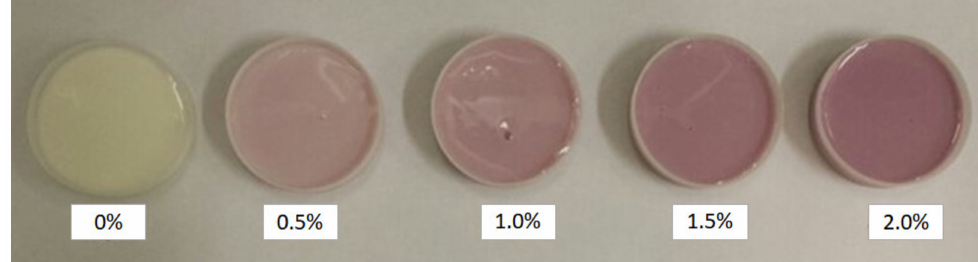
Figure 1. Appearance of the sweetened plain whole-fat yogurt control sample (0%, without pig- ment) and samples with jabuticaba skin powdered extract addition at different concentration levels immediately after blending ( w / w